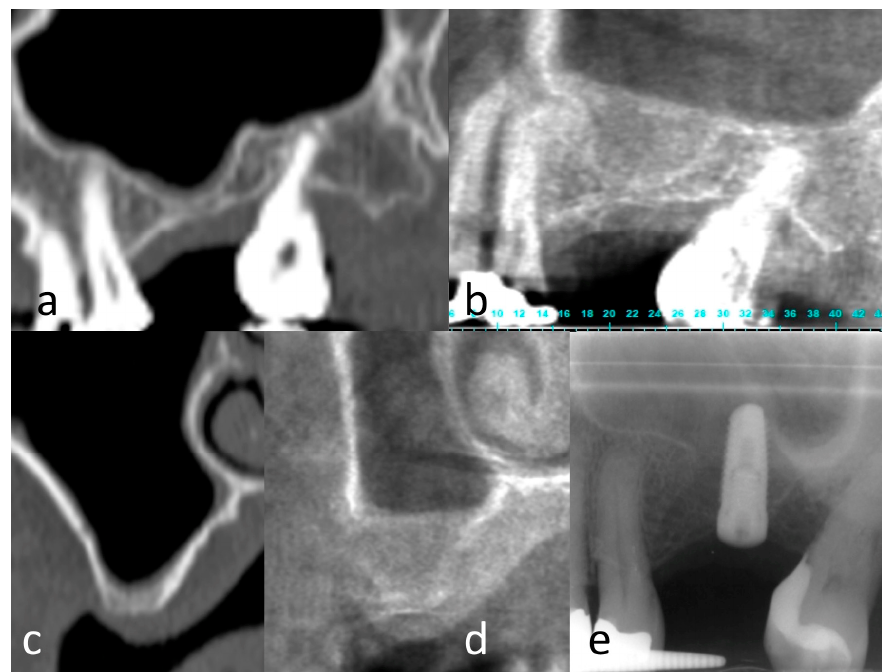
Figure 5. PLGA/HA group. ( a , c ) Computed Tomography of left sinus showing a residual bone height insufficient to implant positioning in panoramic and cross-sectional view; ( b , d ) Cone Bean Computed Tomography of the same site of ( a , c ) six months after sinus floor elevation surgery; ( e ) Periapical X-ray after implant positioning in the new-formed bone.